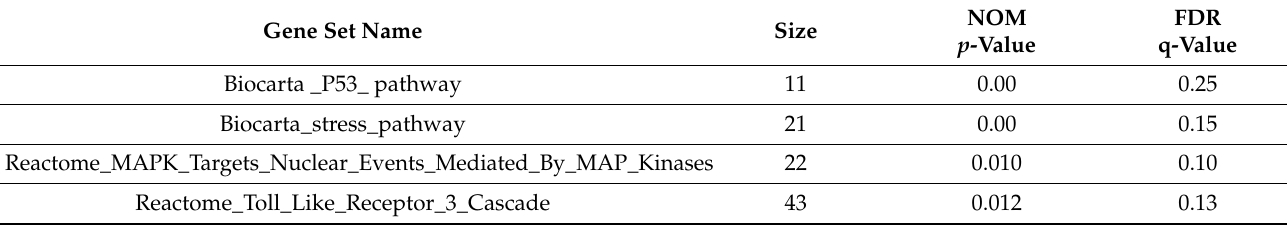
Table 2. Results of GSEA comparing SEA-affected horses and controls. The table reports the 18 gene sets enriched in the SEA group and the number of genes involved in the single-gene set (Size). The nominal p -value (NOM p -value) and the false discovery rate (FDR q-value) have been